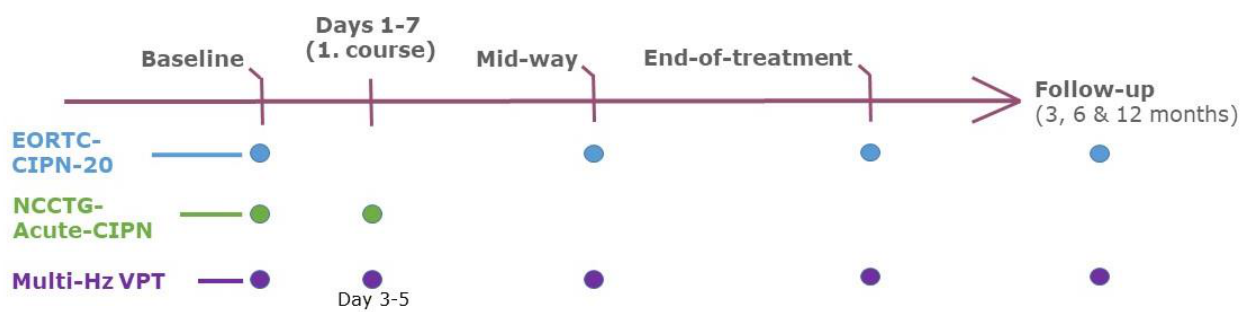
Figure 1. Schematic overview of patient procedures and evaluations across the study period.